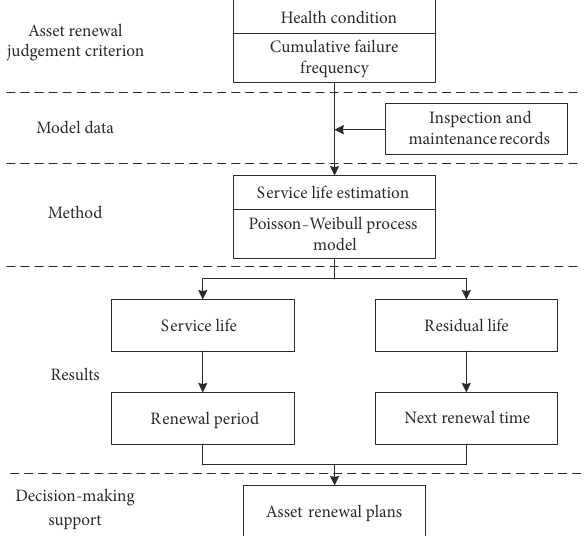
Figure 1. Proposed renewal management framework for urban rail transit